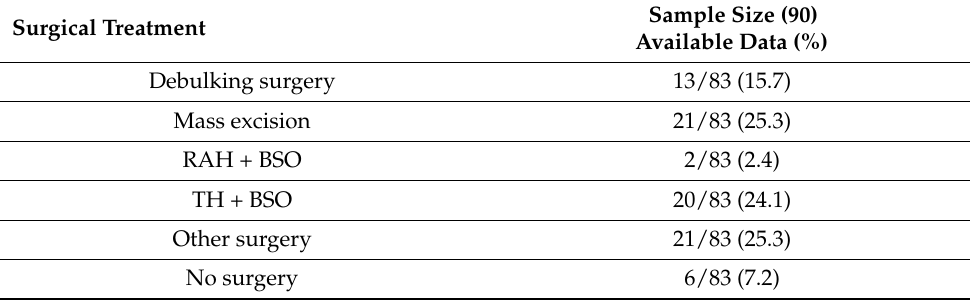
Table 5. Treatment and